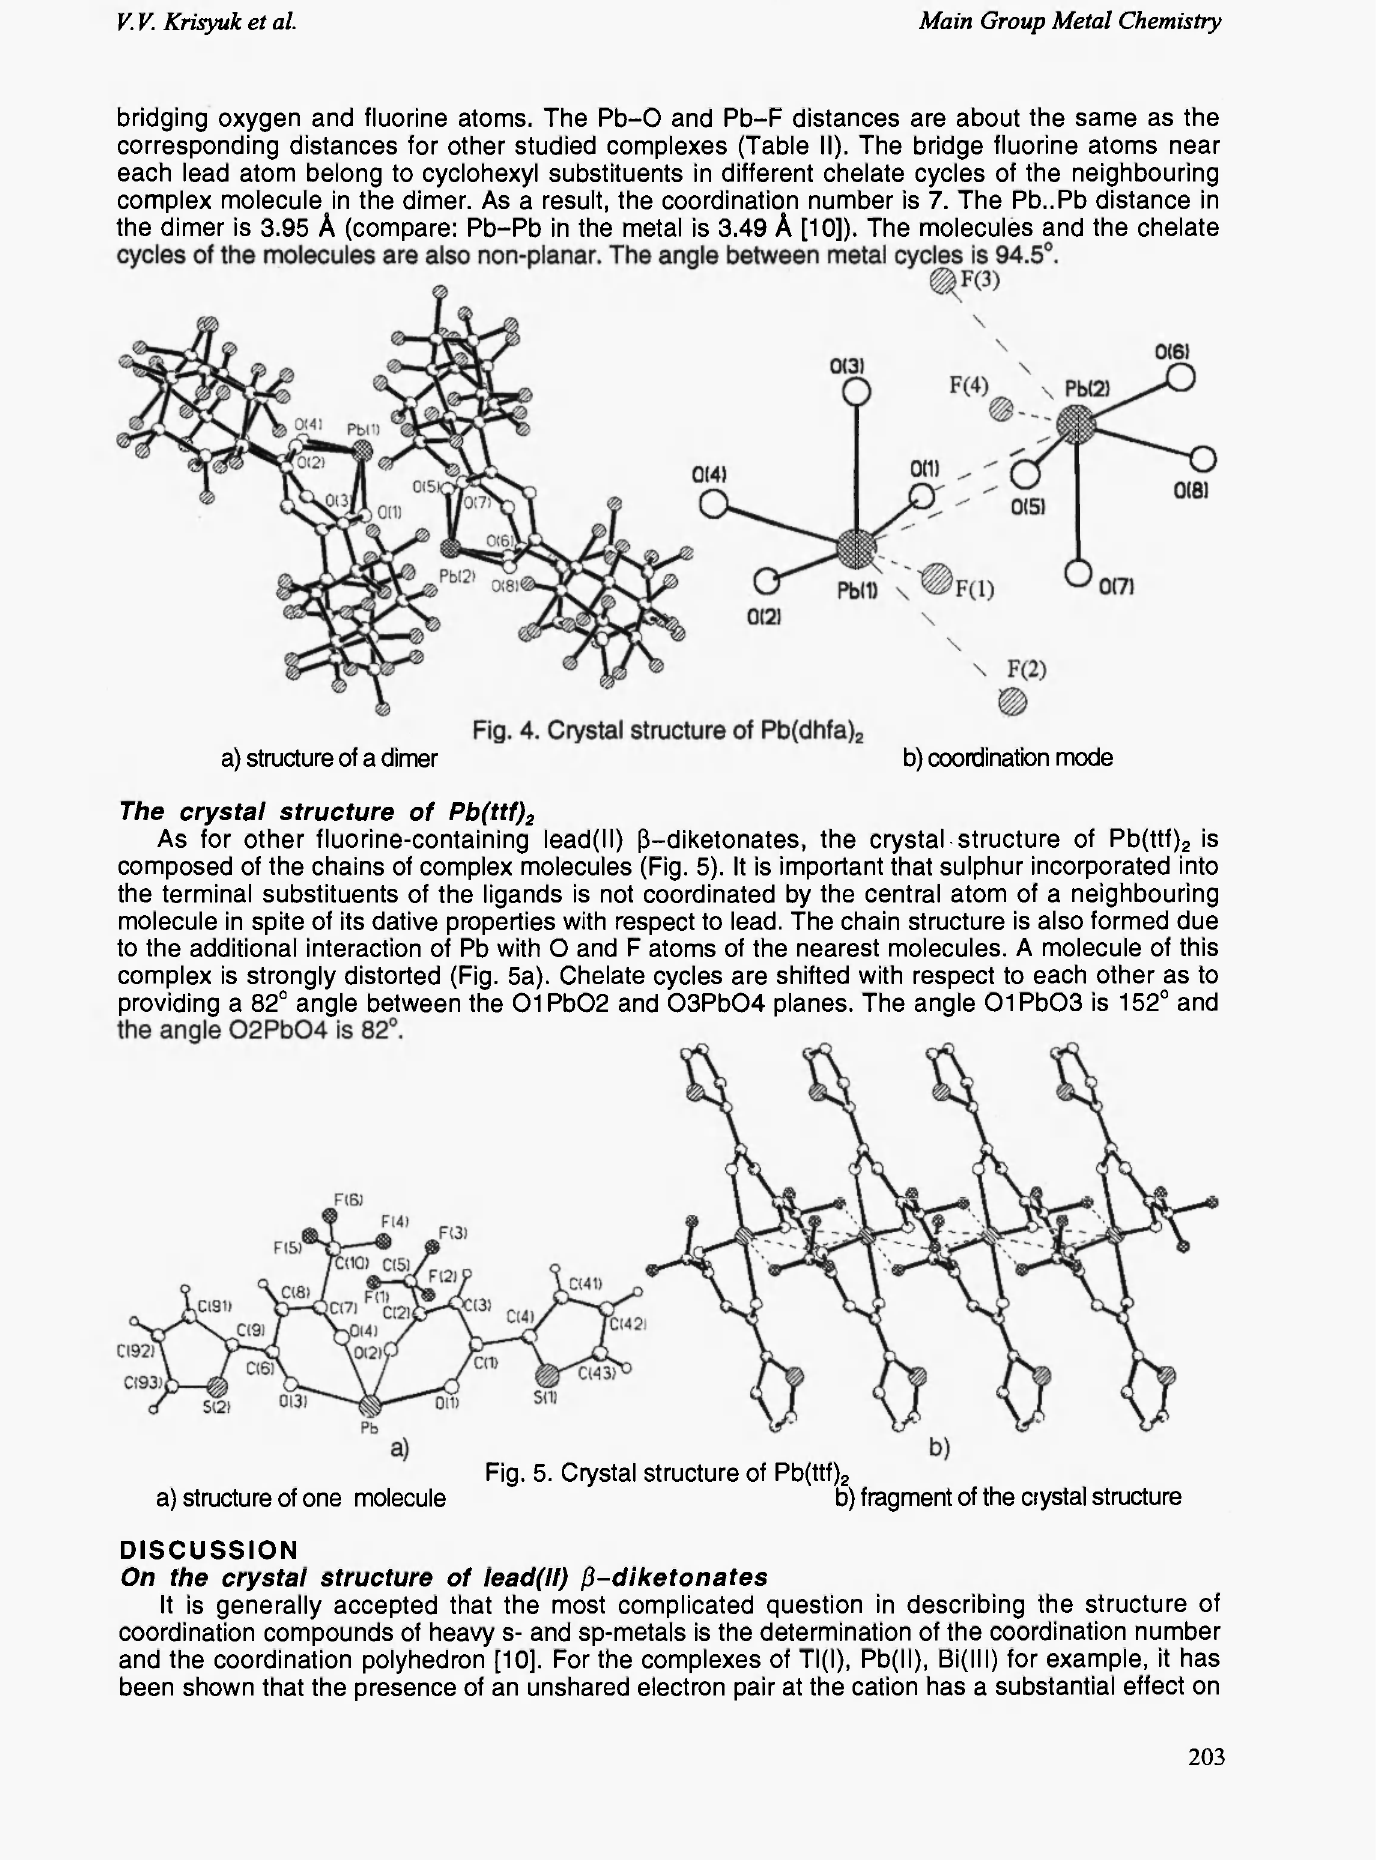
Fig. 5. Crystal structure of Pb(ttf) 2